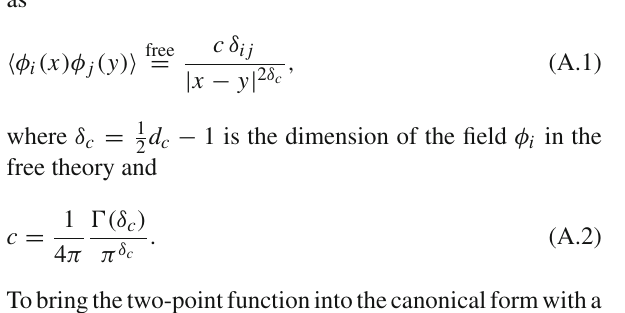
Fig. 1 Wick contraction counting of a three point correlator. The ver- tices are labelled by i = 1 , 2 , 3, the order of the i -th vertex is n i , and there are l ij lines connecting two distinct vertices i and